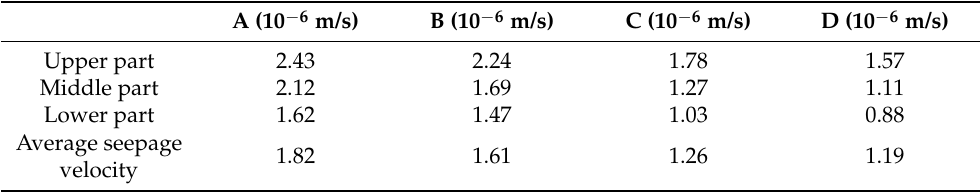
Table 2. Seepage velocity of ore samples at different depths after leaching.